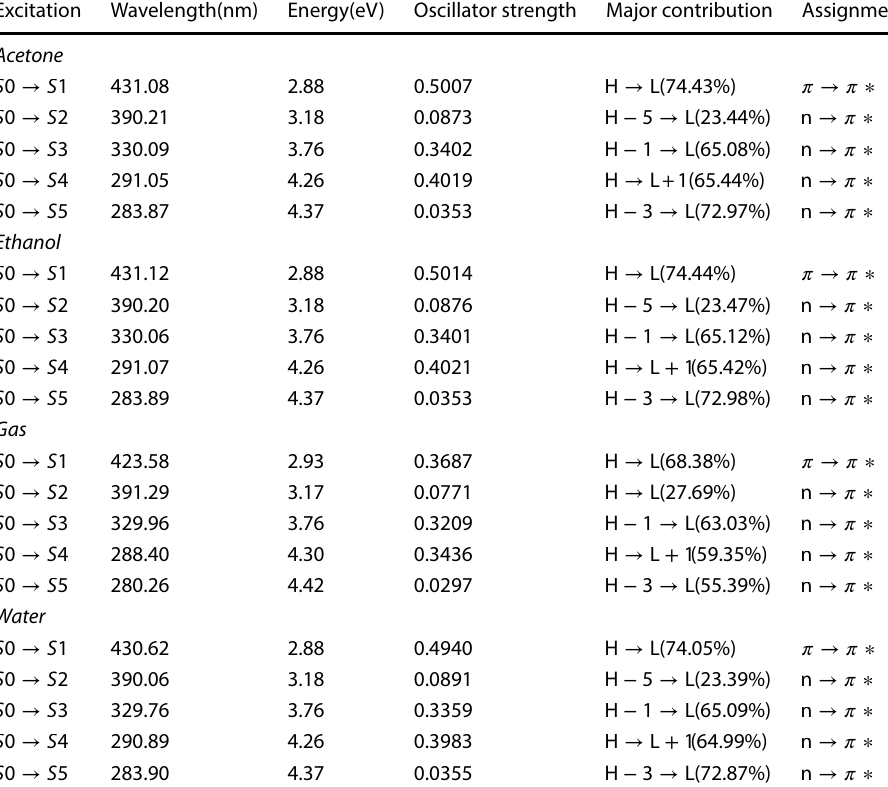
Table 5 Calculated wavelengths of absorption, % contribution from each transition, transition energies, and oscillator strength computed at the B3LYP/6- 31G(d,p)